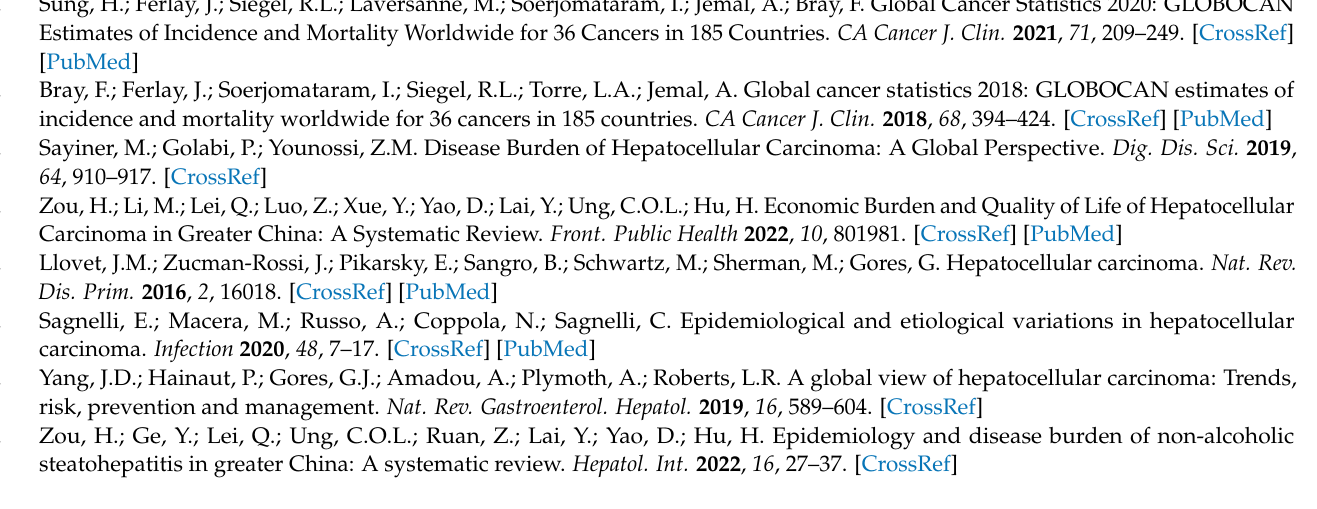
assessing publication bias, Figure S3: Sensitivity analysis, Table S1: Study selection criteria, Table S2: Search strategies, Table S3: Quality assessment of included studies, Table S4: Characteristics of included studies, Table S5: Probable prognostic factors for PFS and OS, Table S6: Pooled analyses of frequently reported TRAEs, Table S7: Publication bias in the pooled analyses of PFS and OS (Egger’s test), Table S8: Publication bias in the pooled analyses of best response (Egger’s test), Table S9: Corrected results of trim and filling method, Table S10: Meta-regression analysis for sources of heterogeneity in the estimates, Table S11: Comparisons of study designs, patient characteristics,